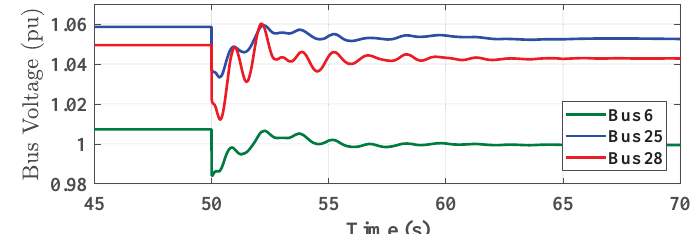
Figure 5. Bus 6, 25, and 28 voltage magnitude responses to G5 trip at t = 50 s for the conventional power system case study (case study